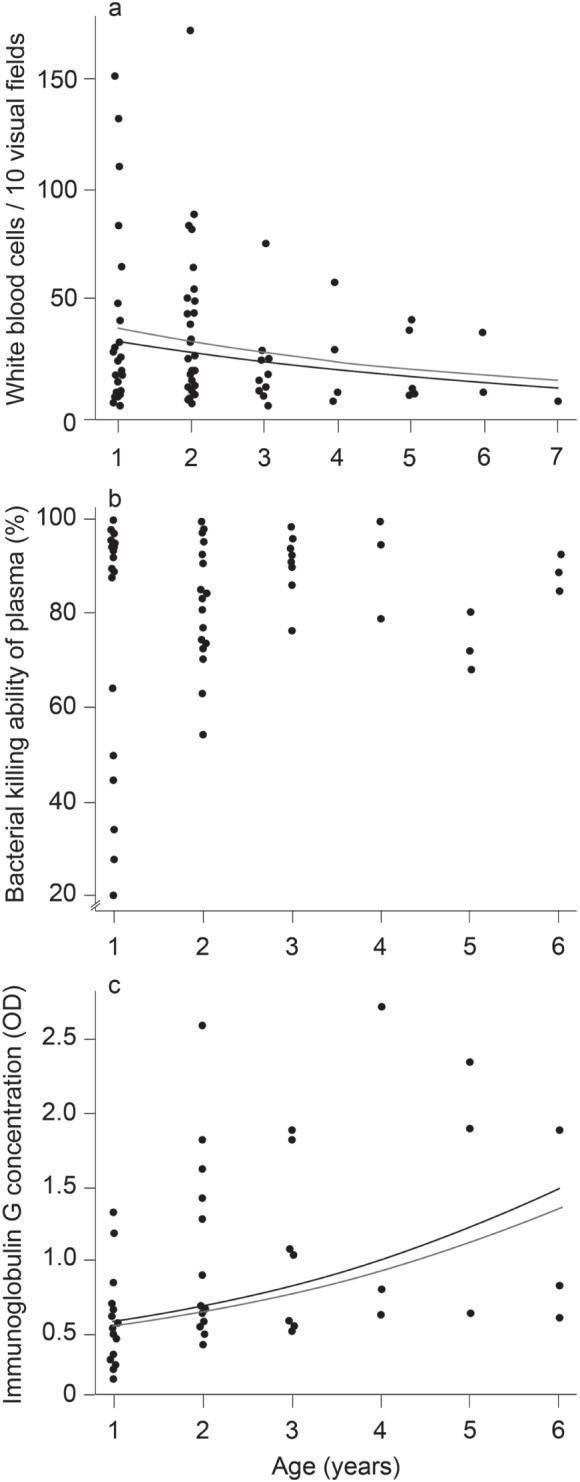
Cross-sectional association between age and immune parameters in S. bilineata.Dots indicate individual measures while solid lines outline the expected values predicted from the statistical models for males (grey line) and females (black line). White blood cell (WBC) count correlated negatively with age (a), while bacterial killing ability (BKA) of the plasma did not change with age (b). Concentration of immunoglobulins (IgG) correlated positively with age (c).